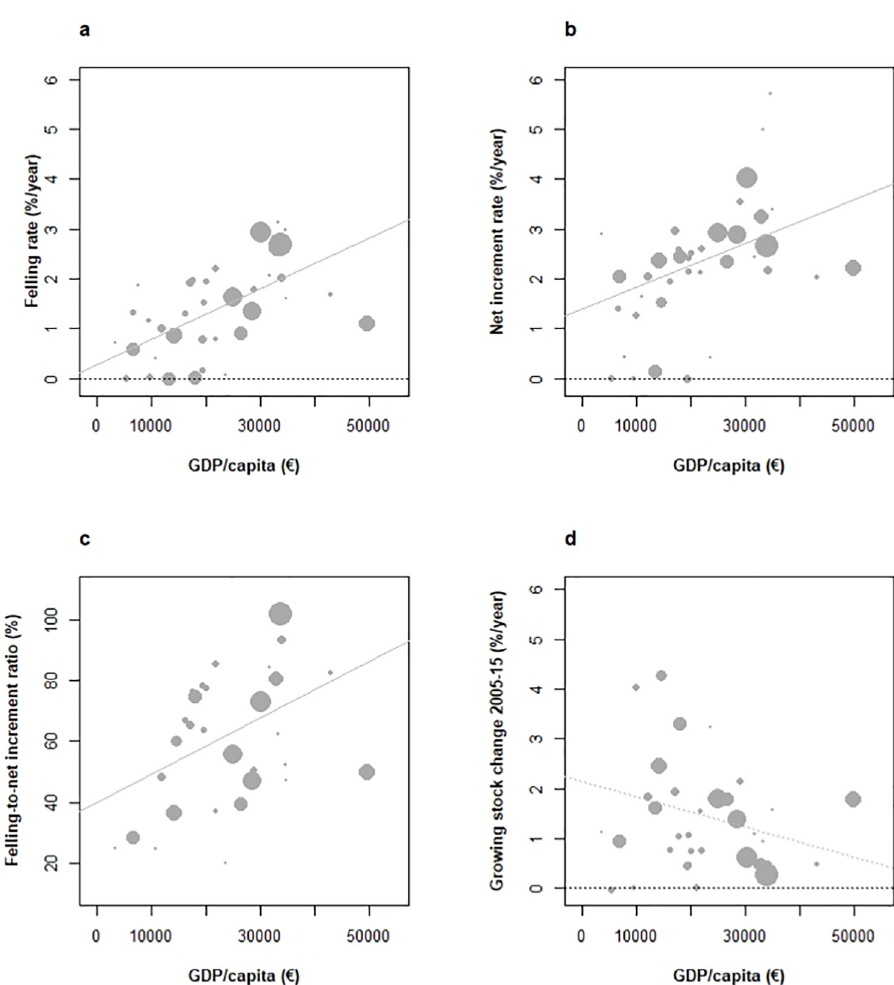
Fig 4. Relationships between GDP per capita and felling and net increment rates (a, b), ratio of felling to net increment (c), and resulting changes in the growing stock over 2005–2015 (d) across European countries under study. Weighted correlations are: (a) +0.57 (p = 10 − 4 ), (b) + 0.48 (p < 0.01), (c) +0.42 (p < 0.05), (c) -0.28 (p < 0.1). NS correlations figured as dotted lines.